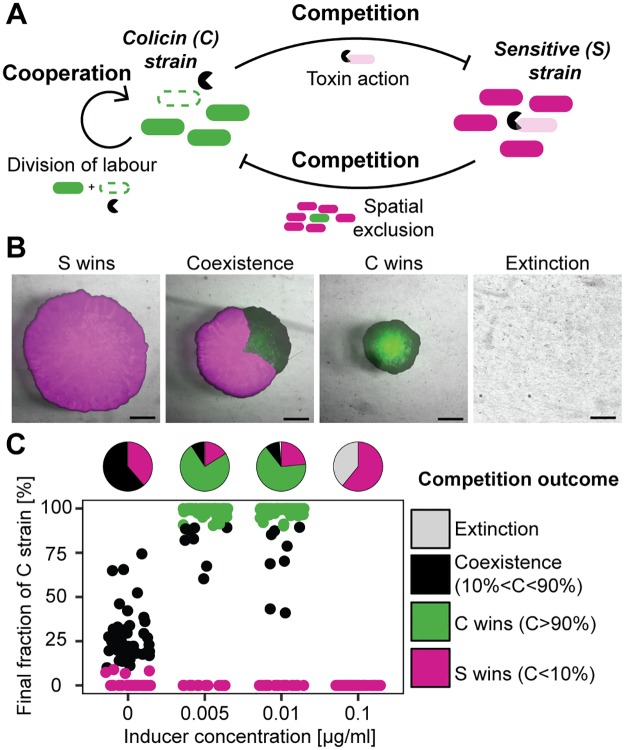
Two-strain competition, strategies, and outcome.C–S competition results in four competition outcomes. The competition outcome distribution changes with increasing inducer concentration. (A) Interaction between a toxin-producing strain (C strain) and a sensitive strain (S strain) is characterized by inter-strain competition (spatial exclusion and toxin action) and intra-strain cooperation within the C strain (division of labor between reproducers and toxin producers). (B) Possible outcomes of competition experiments between sensitive (magenta) and producer (green) cells after 48 h (scale bar = 1 mm). Mitomycin C (MitC) concentrations from left to right: 0.01/0.0/0.01/0.01 μg/ml). (C) Final fraction of C after competition (dot plot) and classified outcomes (pie plots) demonstrate a transition from coexistence and dominance of S (0.0 μg/ml MitC) to dominance of the producer strain (intermediate inducer concentrations, 0.005 and 0.01 μg/ml MitC) and failure of the toxin production strategy (high inducer concentration, 0.1 μg/ml MitC).